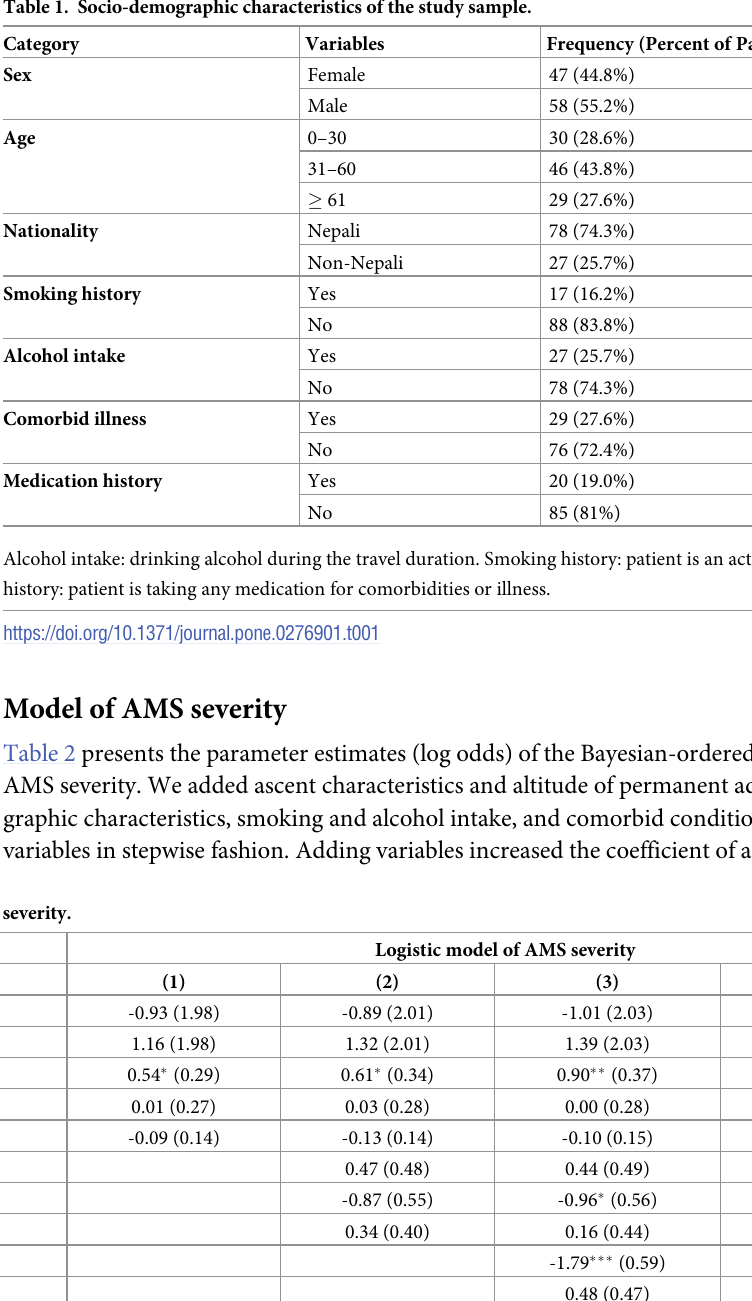
Table 1. Socio-demographic characteristics of the study sample.